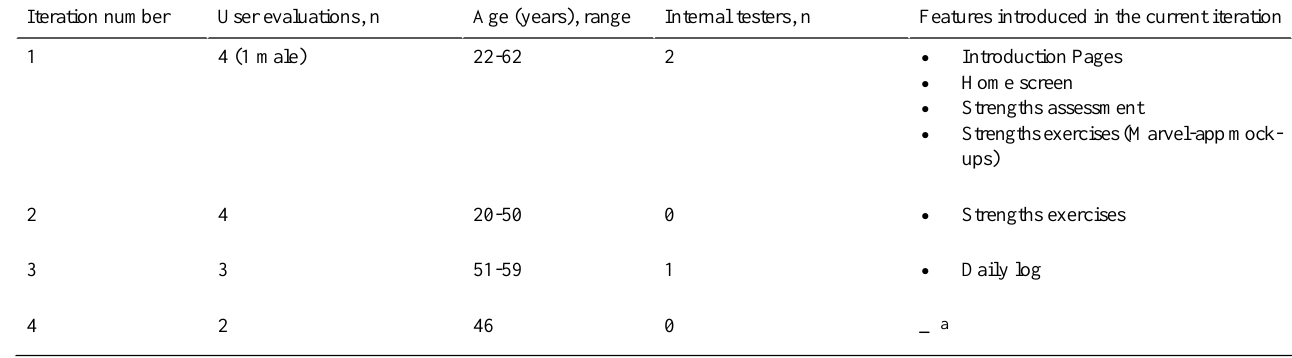
Table 3. Development iterations and users (N=13, 1